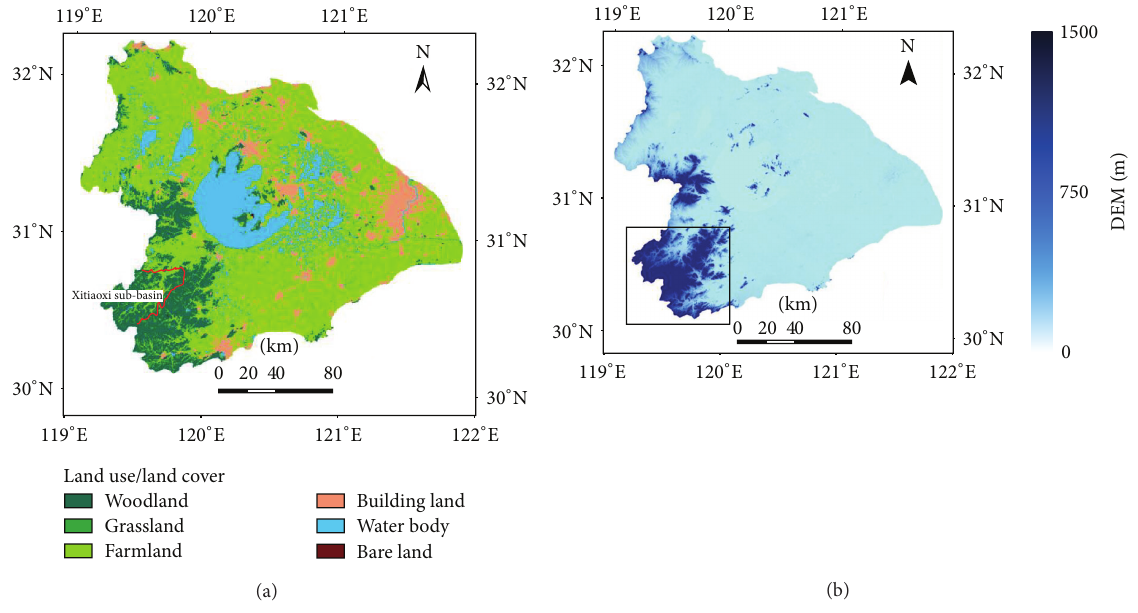
Figure 1: (a) Land cover map (a) and (b) digital elevation model (DEM) of the Taihu Basin in which the study area (in black square) was selected in mountainous